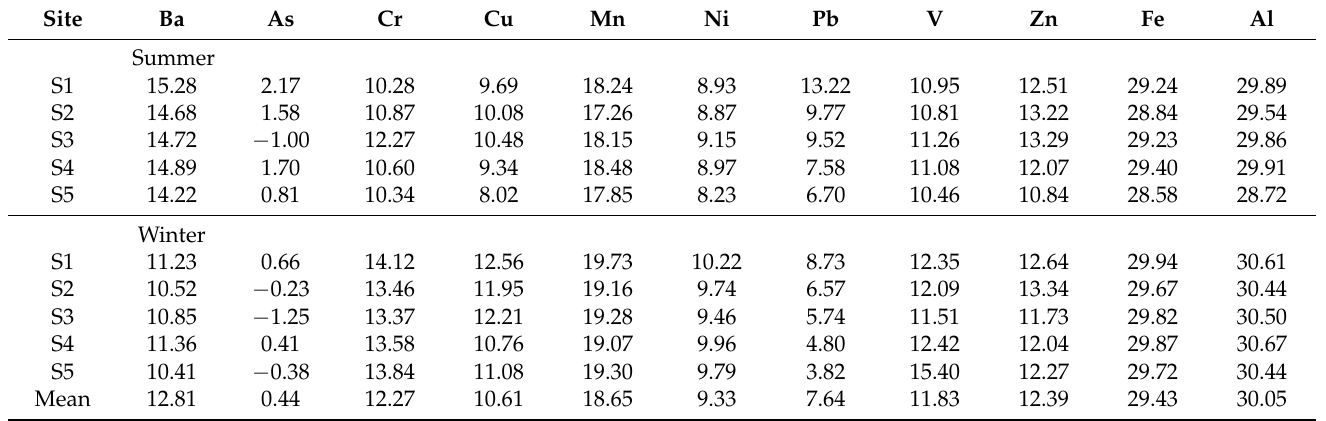
Table 7. The geo-accumulation index (I geo ) of the investigated metals in the drain sediment